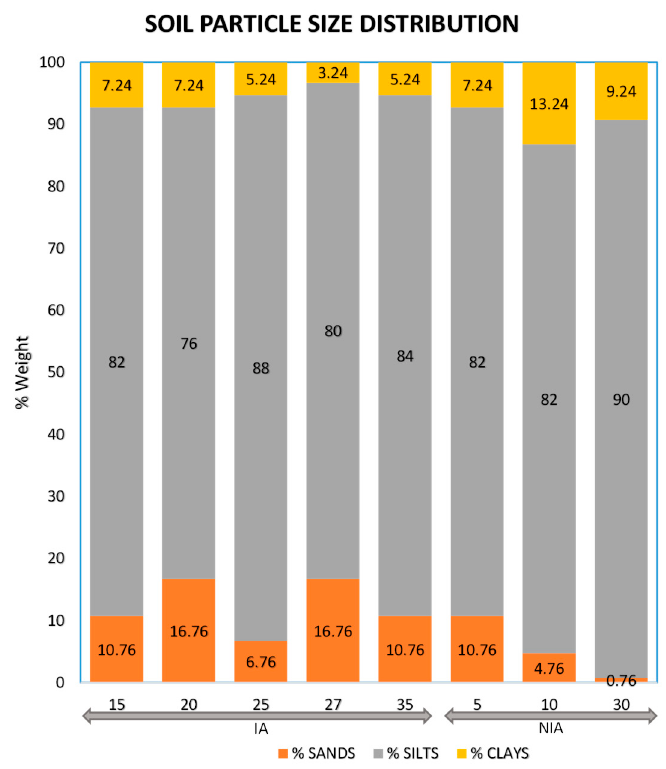
Figure 4. Soil particle size distribution (%) in eight samples collected from irrigated (IA) and non-irrigated areas (NIA) at the study site.